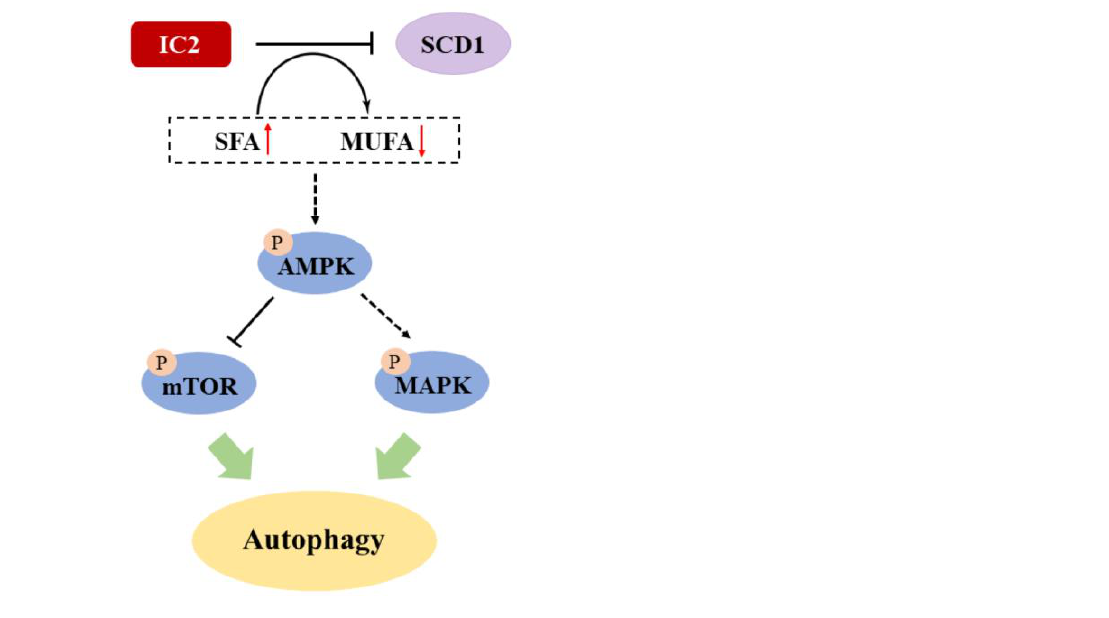
Figure 7. Proposed mechanism of IC2-induced autophagy in breast cancer cells. Solid lines indicate direct modification and dotted lines indicate tentative modification.